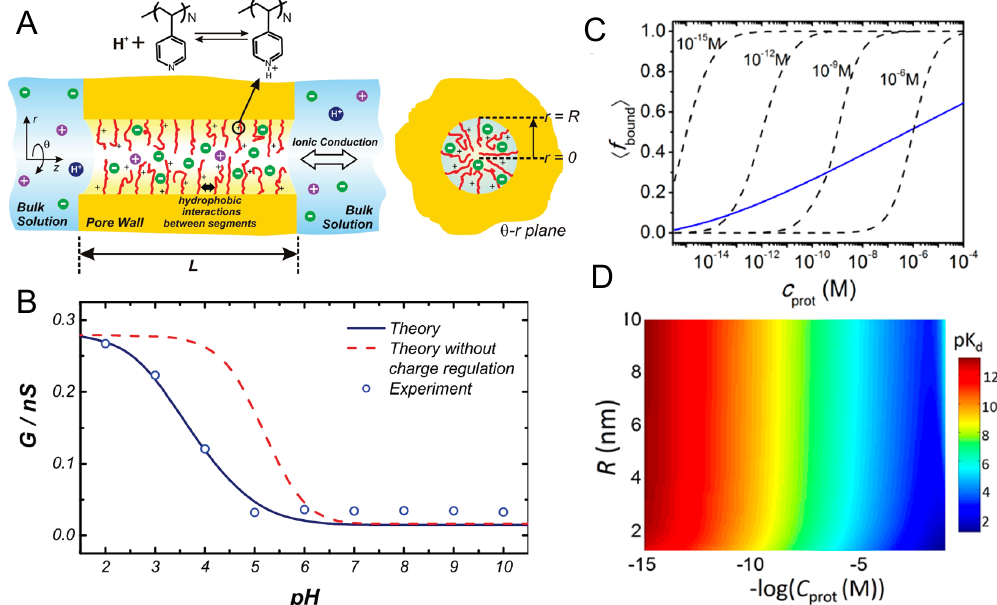
Figure 10. Shifted equilibria of chemical reactions in polymer-coated nanopores. ( A ) Schematic representation of the polyelectrolyte brush modified long nanopore. The inner surface of the pore is modified with end-tethered chains of poly(4-vinyl pyridine). ( B ) Comparison between experiment and molecular theory on the pH-dependent conductivity. Reprinted with permission from the authors of [27]. ( C ) Molecular theory prediction of average fraction of bound ligands inside a nanopore as a function of the molar concentration of the proteins in bulk solution (solid blue line), in comparison with the predictions of the Langmuir isotherm for different values of the dissociation constant (black dashed lines). ( D ) Apparent dissociation constant as a function of the pore radius and the molar concentration of the proteins in bulk solution. (Reprinted with permission from the authors of